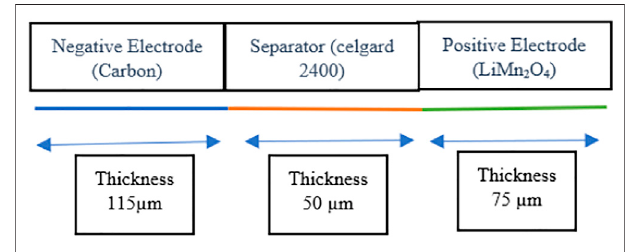
FIGURE 7 | One-dimensional schematic model of solid-state lithium-ion battery.